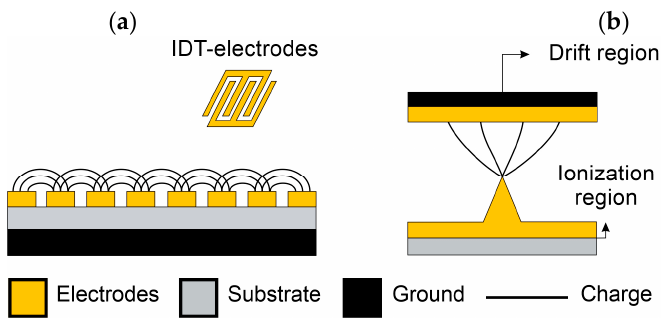
Figure 7. Schematics of electrical sensors. ( a ) Capacitive. ( b ) Corona discharge.